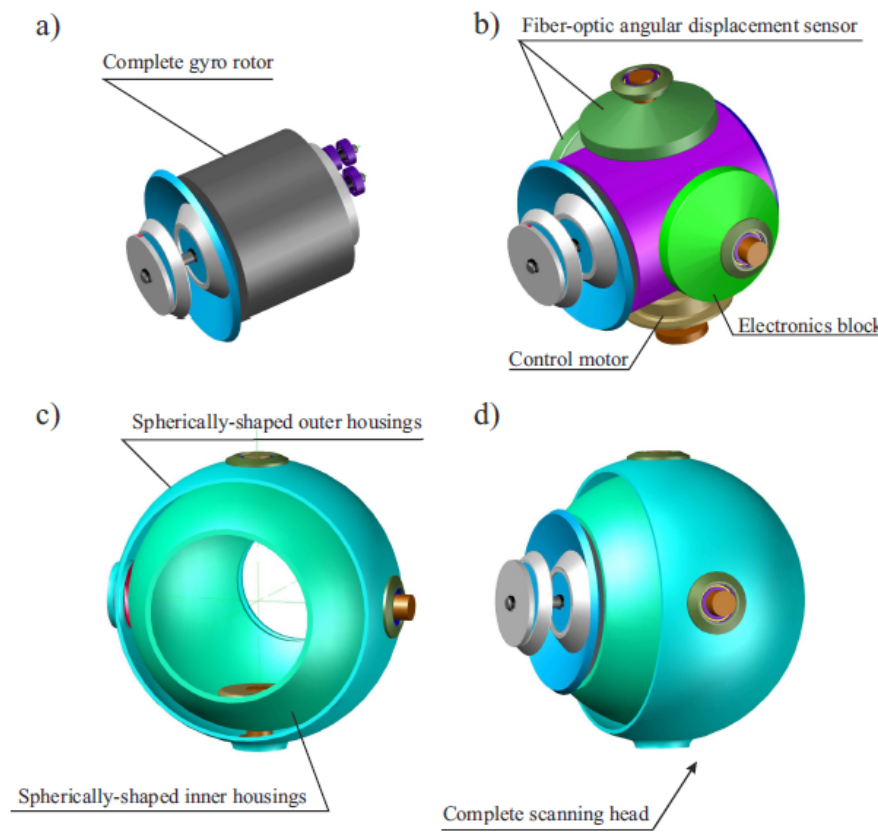
Figure 1. 3D view of the designed scanning and tracking seeker, where: ( a ) gyro rotor of scanning system; ( b ) sensors and control motors of the seeker; ( c ) spherically-shaped forming a cardan arrangement; ( d ) complete scanning head.